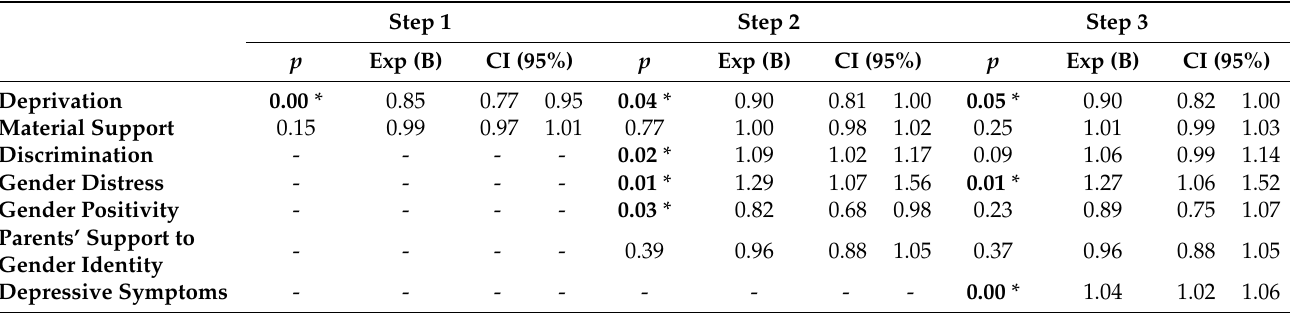
Table 4. Poisson Regression—suicidal